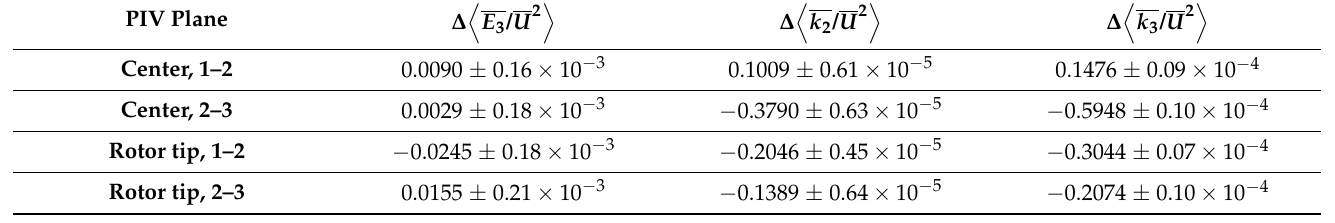
Table 4. At each PIV measurement location, the differences between treatment and control of the spatially averaged and normalized MKE and TKE and the 95% confidence interval are given. Calculation for each is given in the text. Note that all differences are significant and that a positive difference indicates greater energy in the treatment case.